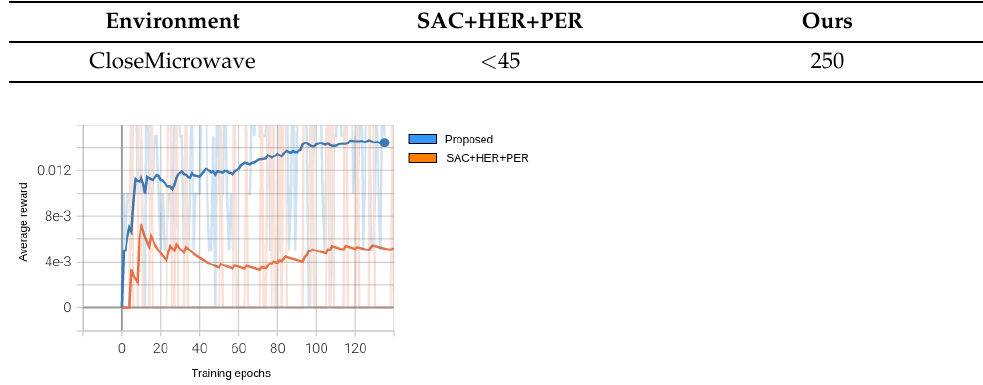
Figure 5. Average reward results for SAC+HER+PER versus the proposed method in the CloseMi- crowave, which is the target task in multi-task setting. The blue line indicates the proposed method, whereas the orange line indicates